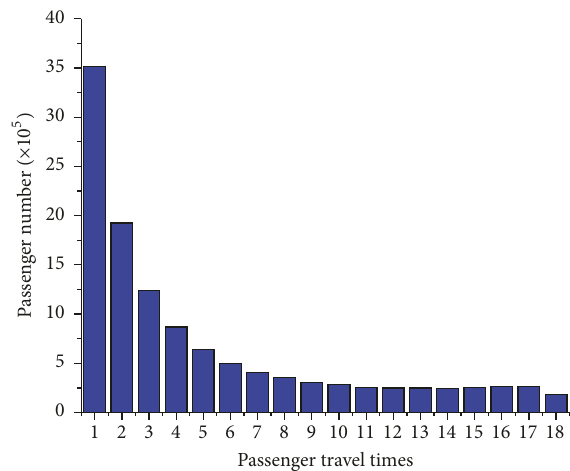
Figure 2: The relationship between passenger number and passen- ger travel times.